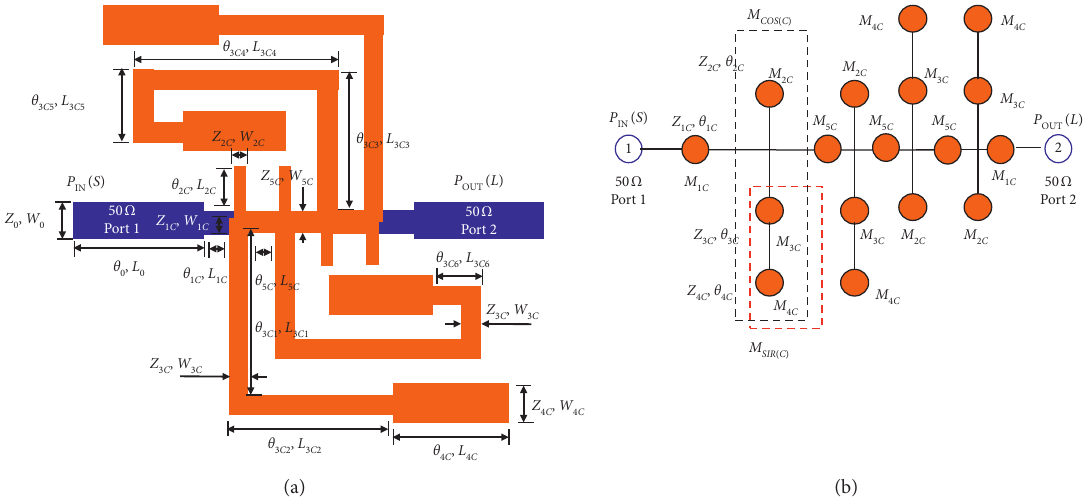
Figure 7: (a) FQC-SSIR structure and (b) the ABCD matrix structure for the